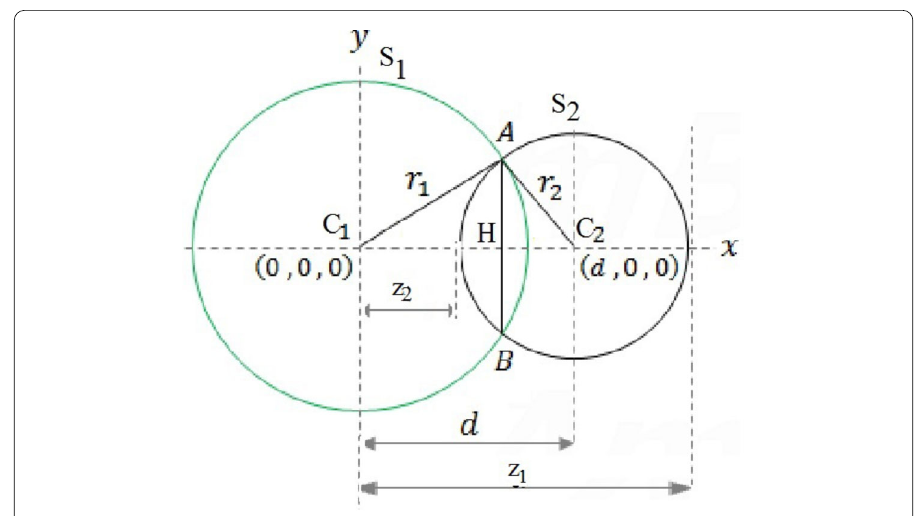
Figure 2 Two intersecting spheres S 1 and S